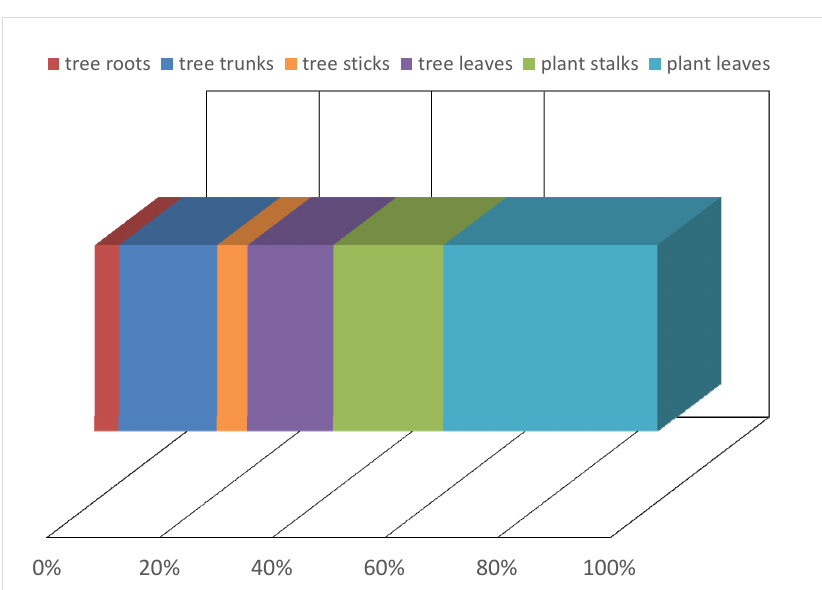
Figure 5. Proportion of different types of emergence sites of Cordulegaster heros . Emergence sites were located at different distances from the shoreline and at differ ‐ ent heights. Specifically, exuviae were noted from 0 to 790 cm ( ẍ = 154 cm) at a horizontal distance from the shore and from 10 to 310 cm ( ẍ = 77 cm) at a vertical height above the ground. The total distance of larval movement ranged from 10 to 1080 cm ( ẍ = 205 cm) (Figures 7 and 8).